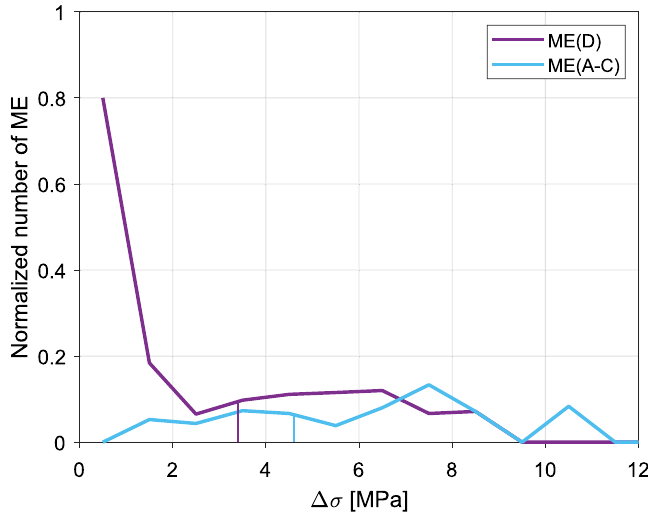
Figure 6. Number of ME(D) and ME(A–C) normalized to the total number of events in 1 MPa ∆σ intervals . Median ∆σ values within each group are marked with solid vertical